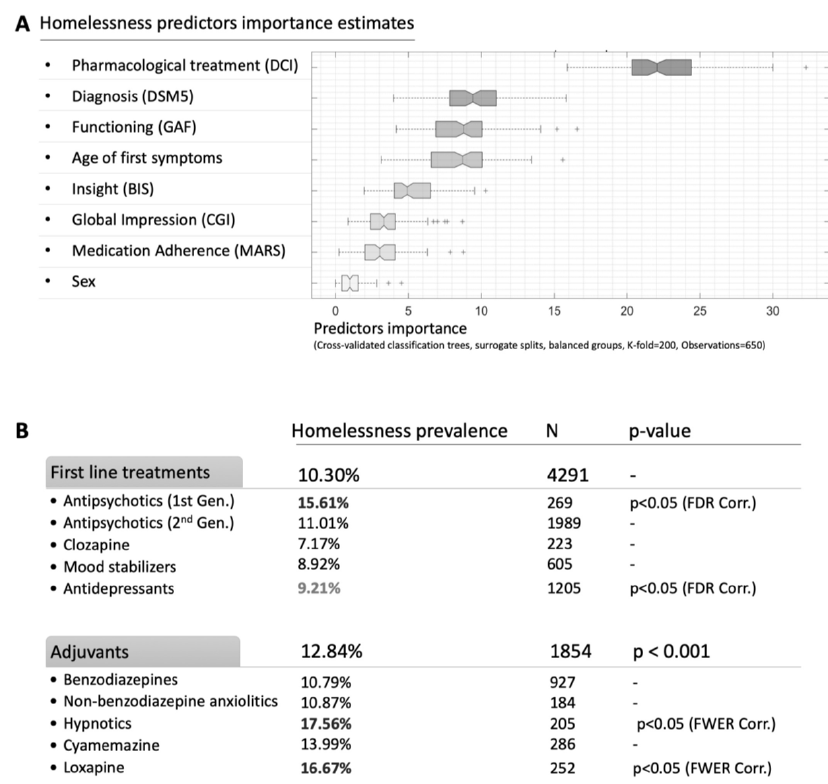
Figure 1. ( A , B ): Estimates of the importance of predictors of